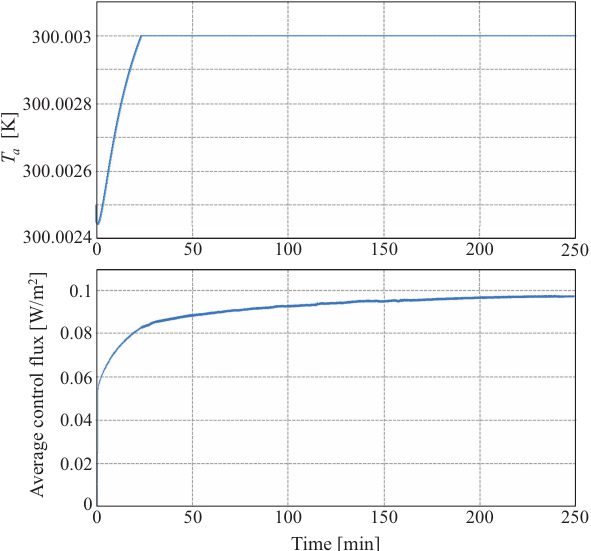
Figure 9. Closed loop simulation results with a contact resistance of 0.1 K/(W/m 2 ) and heat losses of 500 W/(m 3 K). Evolution of the average temperature ( top ) and the estimated heat flux ( bottom ) in the thermopile. At t = 0 the thermopile contacts the surface of the